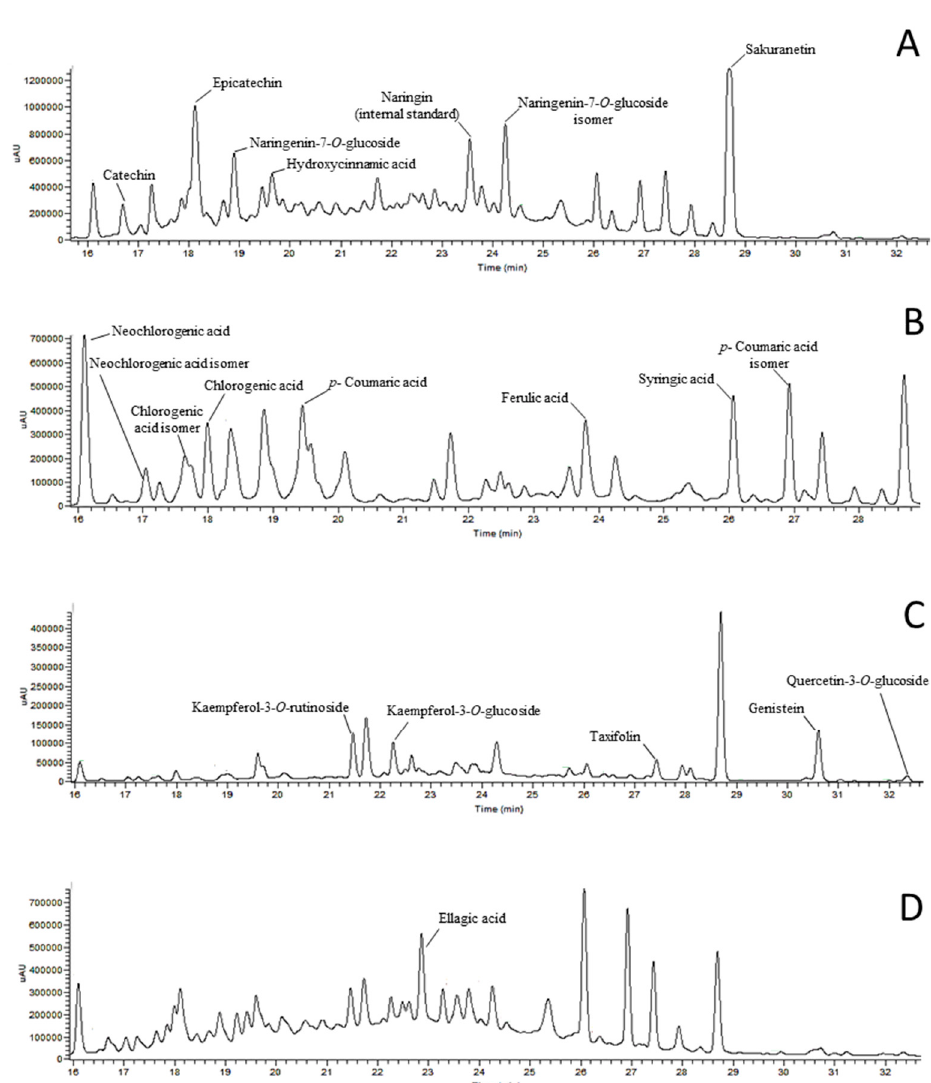
Figure 2. Example of a HPLC chromatograms of phenols detected in sweet cherry stem’s extracts, recorded at different wavelengths: 280 nm ( A ), 320 nm ( B ), 370 nm ( C ) and 254 nm ( D ).